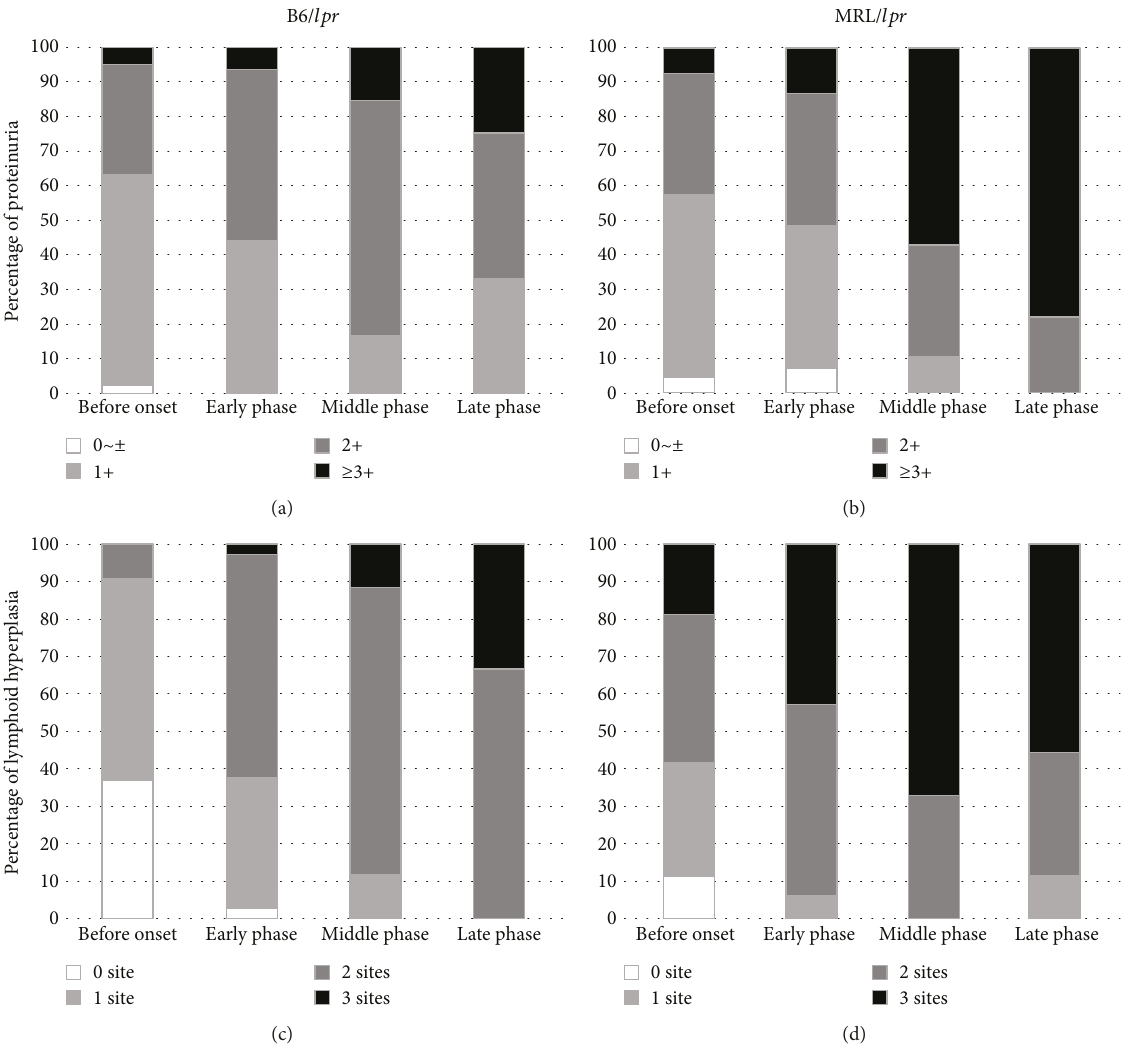
Figure 1: Cumulative prevalence of proteinuria and lymphoid hyperplasia. Urine protein and lymphadenopathy were monitored every week, starting at 6 weeks of age. Urine protein measured using tetrabromophenol paper over time in the B6/ lpr (a) and MRL/ lpr (b) mice. Cervical, axillary, and inguinal lymph node hyperplasias, 5mm or larger, were monitored visually in the B6/ lpr (c) and MRL/ lpr (d)